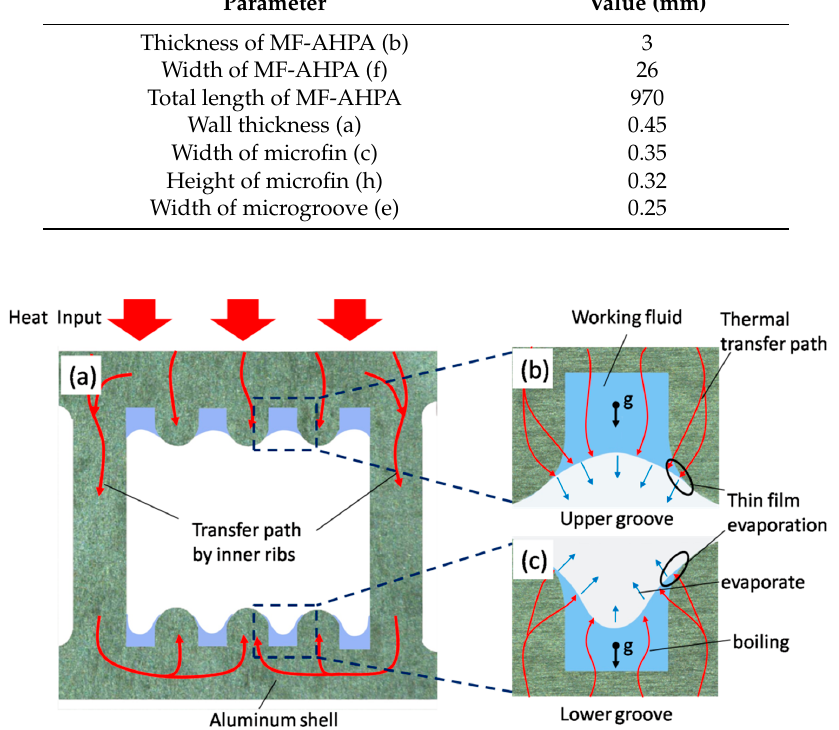
Table 1. Key dimensions of MF-AHPA.